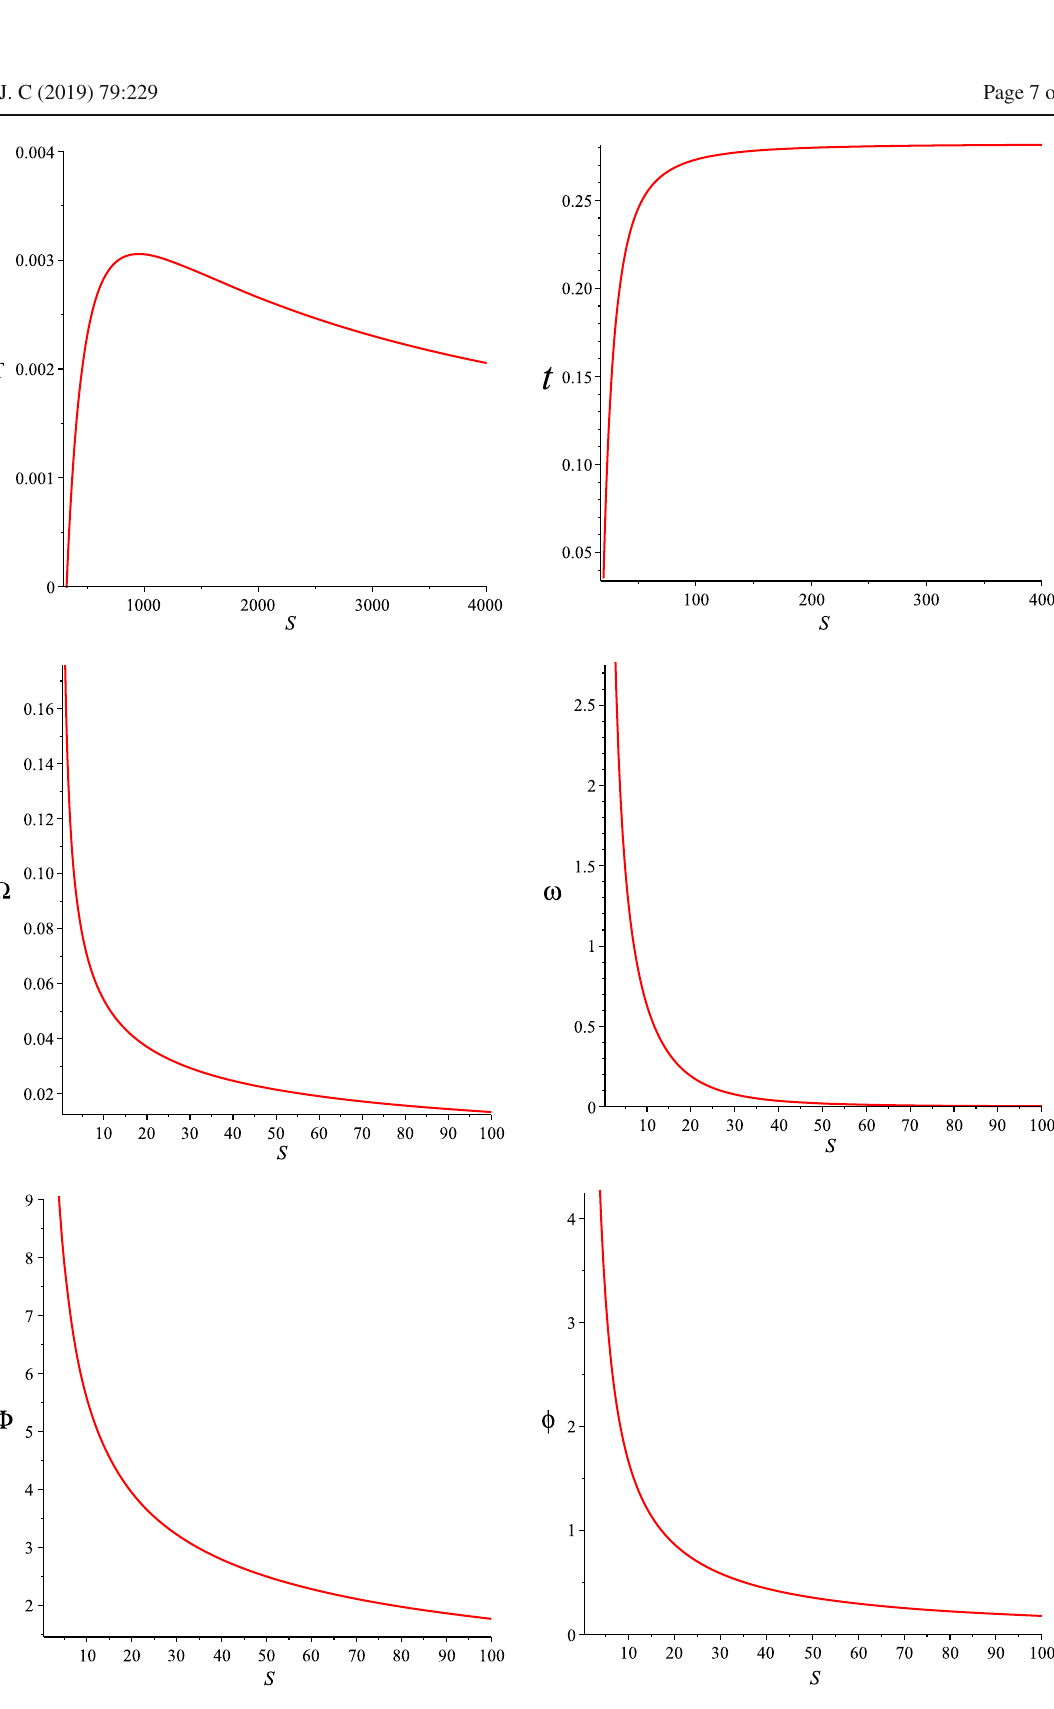
Fig. 2 Behavior of the intensive quasi-homogeneous ( T , (cid:17) , (cid:2) ) and homogeneized ( t , ω , φ ) as functions of the quasi-homogeneous entropy S and the homogeneized entropy s for the particular values J = j = 5 and Q = q =